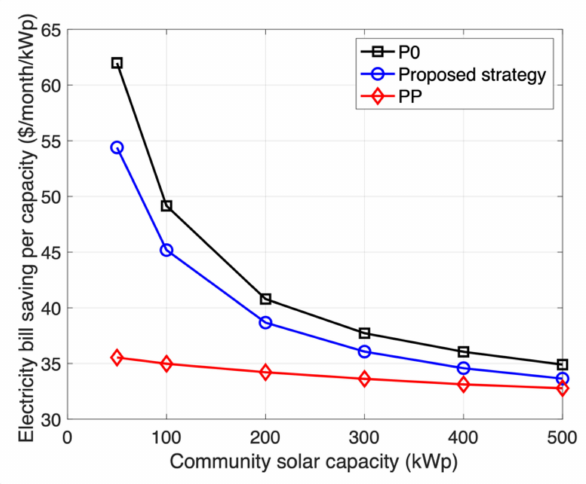
Figure 8. Electricity bill savings per community solar capacity.